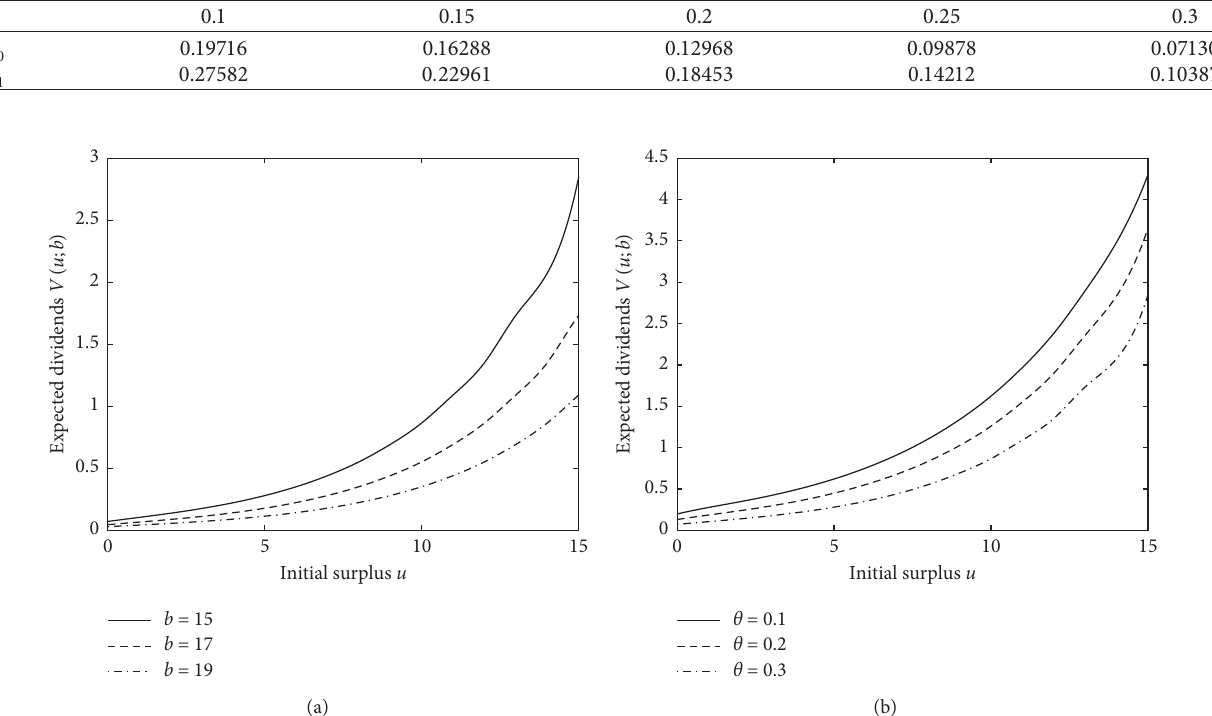
Figure 1: Impact of θ and b for V ( u ; b ) . (a) Numerical results for V ( u ; b ) when θ � 0 . 3. (b) Numerical results for V ( u ; b ) when b � 15.